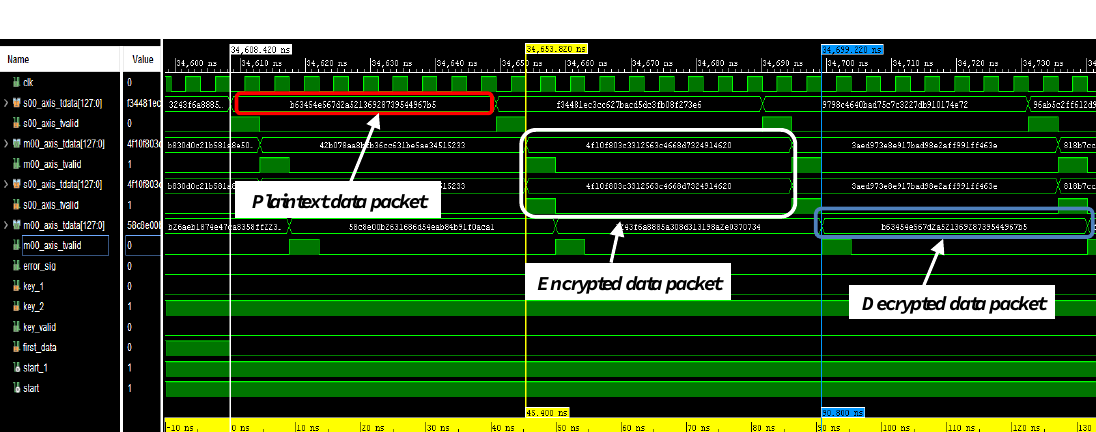
Figure 21. Temporal trends related to the behavioral simulations where plaintext data packets are provided every 9 system clock periods at 220 MHz, corresponding to a data rate of 3.123 Gbit/s.